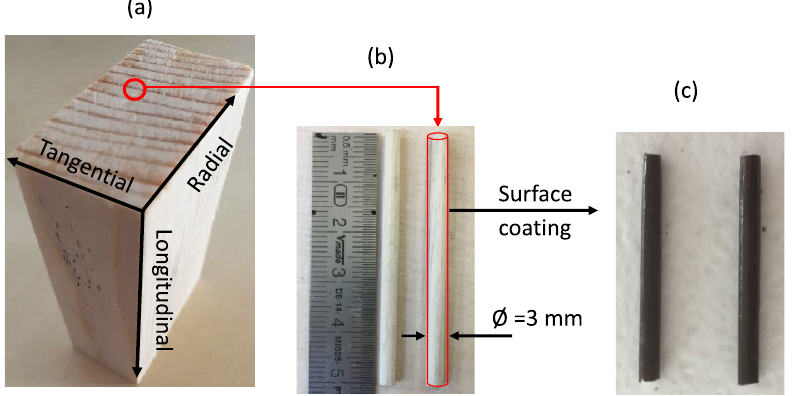
Figure 1. Sample preparation ( a ) macroscopic sample (Spruce here) prepared along the orthotropic directions: radial (R), 40 mm; tangential (T), 20 mm; and longitudinal (L), 100 mm, for macroscopic imbibition test; ( b ) small wood cylinder of 3 mm diameter and 50 mm length prepared for microscopic tests observed with the X-ray tomography, and ( c ) wood specimens sealed by a water-impermeable paint (aqua-stop) to avoid any capillary effect at the external face (photographs by M.